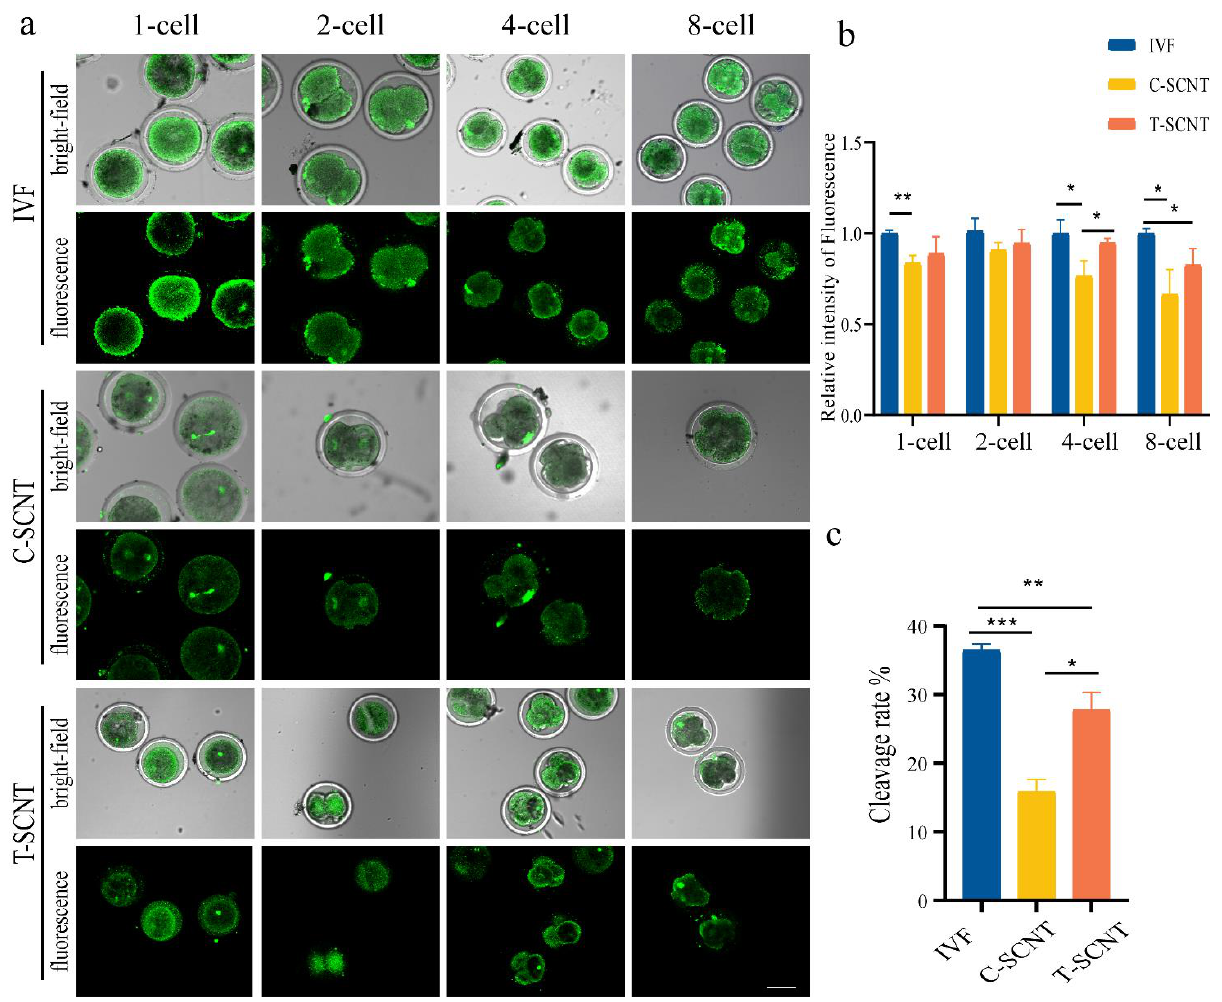
Figure 5. Effect of treatment of donor cells (MDSCs) with NaCr on the level of Kcr and developmental competence in SCNT embryos. ( a , b ) Fluorescence staining pattern and relative fluorescence intensity of Kcr level in IVF and MDSC SCNT embryos (C-SCNT and T-SCNT) at different stages (scale bar, 50 µm). ( c ) The cleavage ratio of embryos at all cleavage stages in IVF, C-SCNT, and T-SCNT. the C-SCNT (control SCNT) and T-SCNT (experimental SCNT) group represent cloned embryos generated with untreated and NaCr-treated donor cells (MDSCs), respectively. IVF group represents blank control group; * p < 0.05, ** p < 0.01, *** p < 0.001; no asterisk indicates no significant